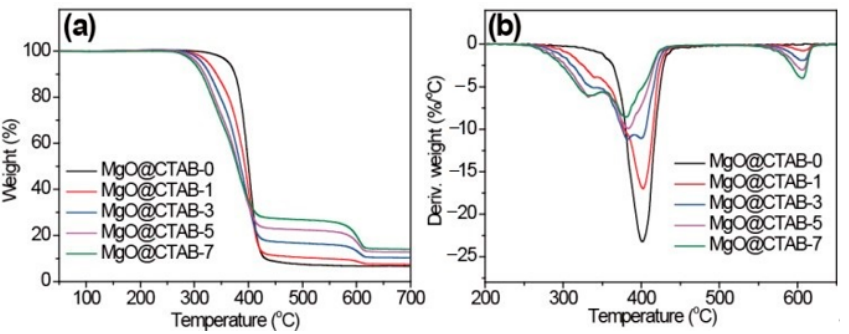
Figure 6. TGA curves of PBAT/MgO@CTAB nanocomposites. ( a ) TGA, ( b ) DTG. Table 2. Thermal stability of PBAT and its nanocomposites.